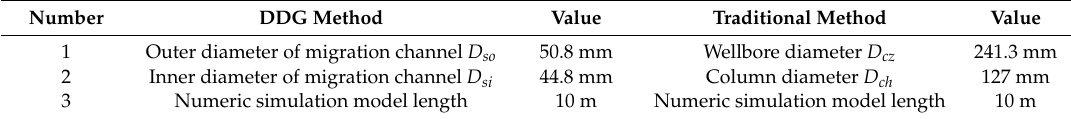
Table 2. Two methods of horizontal-channel migration channel